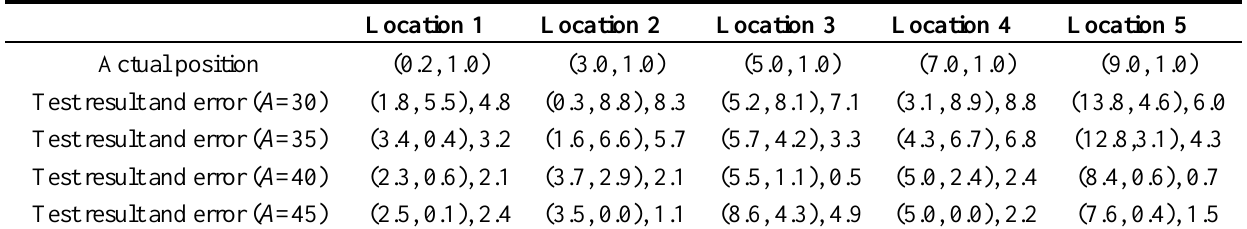
Table 6 . The experiment test results and error (in meters), n = 3.875.